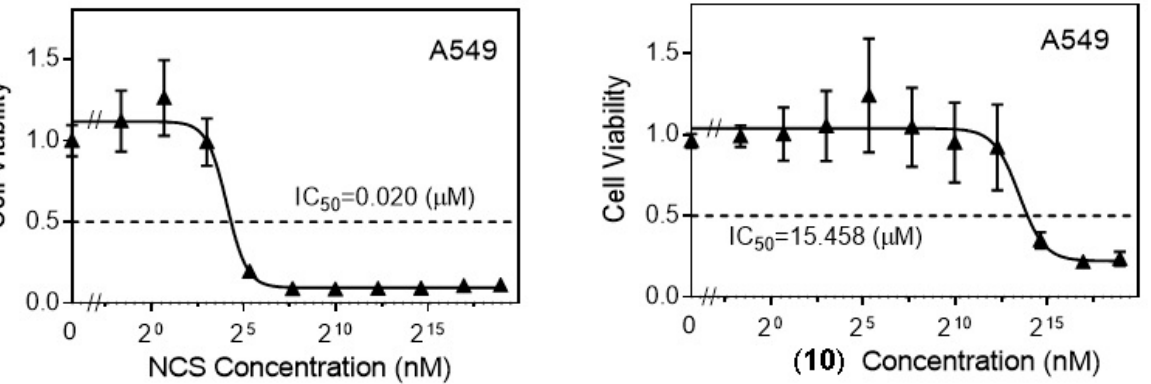
Figure 2. Dose ‐ dependent cytotoxicity of compounds in lung cancer cell line A549 . Cells were treated with a series of dilutions of the compounds in 96 ‐ well plates for 4 days, and cell viability was measured using MTT assay. Shown in each figure is dose ‐ dependent response to the indicated compound, with the dotted line signifying the IC50.